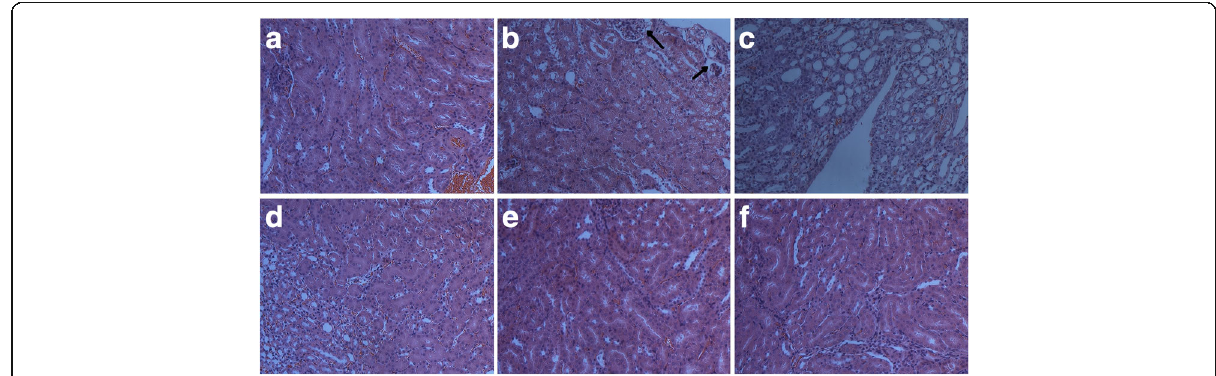
Fig. 4 Histology of the kidney, H & E Stain, 200×. ( a ) Blank group, ( b ) Model group with PO, ( c ) Allopurinol 40 mg/kg, ( d ) G. pensylvanicum 100 mg/kg, ( e ) G. pensylvanicum 200 mg/kg and ( f ) G. pensylvanicum 400